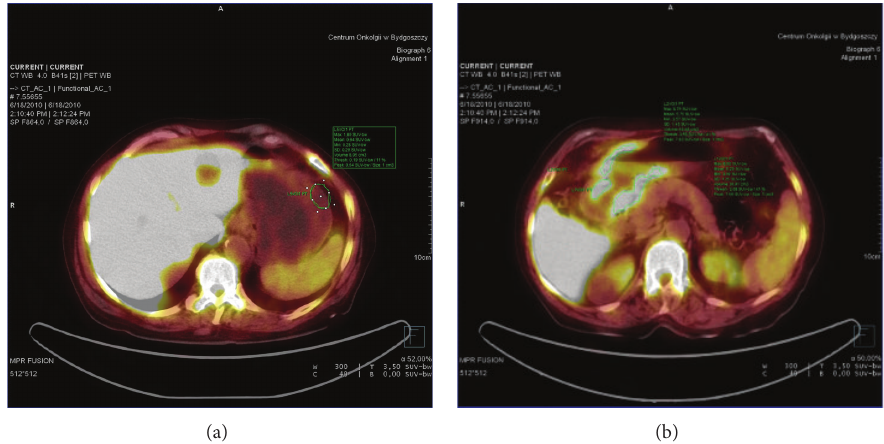
Figure 1: (a) 18 FLT-PET in patient with undifferentiated adenocarcinoma. SUV max in normal gastric wall was 1.8. (b) 18 FLT-PET in patient with undifferentiated adenocarcinoma. SUV max = 8.9